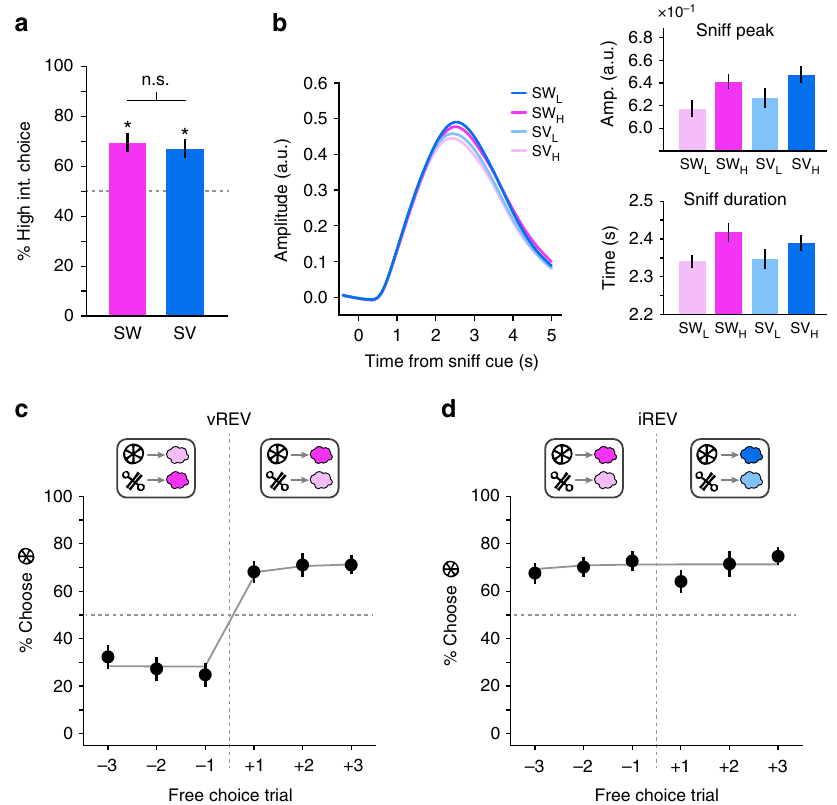
Fig. 2 Choice behavior and sniff responses. a On free choice trials, choices for the high-intensity version of both the sweet and savory US were above chance and did not differ. Error bars depict across-subjects s.e.m. * p < 0.05, t -test vs. chance. b Average trial-wise sniff traces, time-locked to sniff cue onset show a main effect of odor intensity on both sniff peak and sniff duration but no effect of odor identity and no interaction. Error bars depicted within- subjects s.e.m. c Black circles are the percentage of choices for the CS predicting the high-intensity US (post reversal), plotted for three free choice trials before and after value reversals. Average model-derived choice probabilities are plotted in gray lines. The task state schematics above the plot illustrate an example of one possible value reversal, but the data plotted are averaged across all value reversals. Error bars depict across-subjects s.e.m. d Black circles are the percentage of choices for the CS predicting the high-intensity US, plotted for three free choice trials before and after identity reversals. Average model-derived choice probabilities are plotted in gray lines. The task state schematic above the plot illustrates an example of one possible identity reversal, but the data plotted are averaged across all identity reversals and subjects. Error bars depict across-subjects